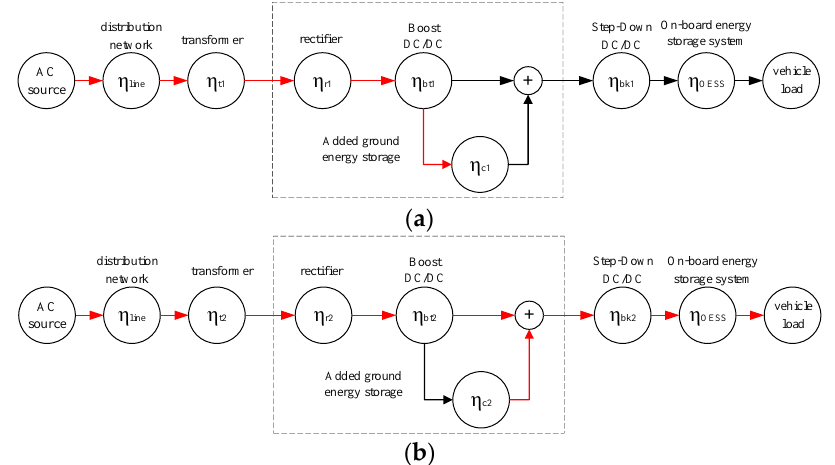
Figure 4. Efficiency flow block diagram of collaborative energy storage charging system. ( a ) Energy storage system charging process. ( b ) Collaborative energy storage system discharge process.